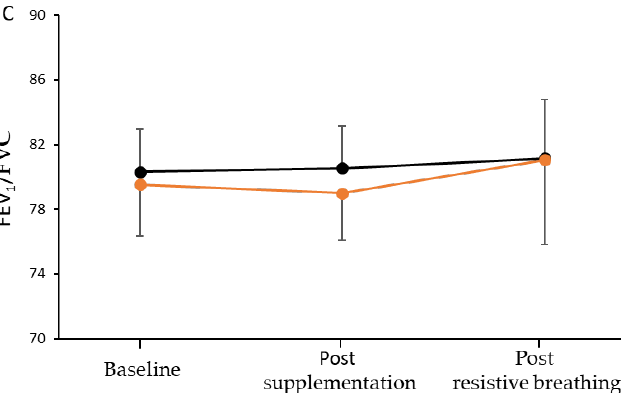
Figure 4. Forced expired volume in 1 second ( A ), forced vital capacity ( B ), and their ratio ( C ) at baseline, after seven days of L-citrulline (orange circles) and placebo (black circles) supplementation and post resistive breathing to task failure.